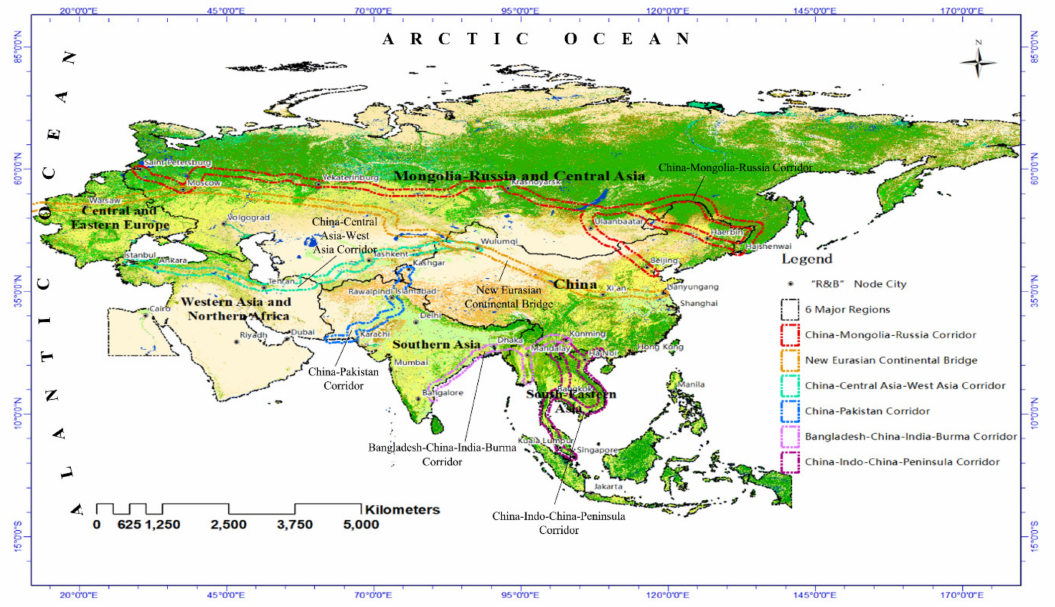
Figure 1. “Belt and Road” monitoring area and corridor map.